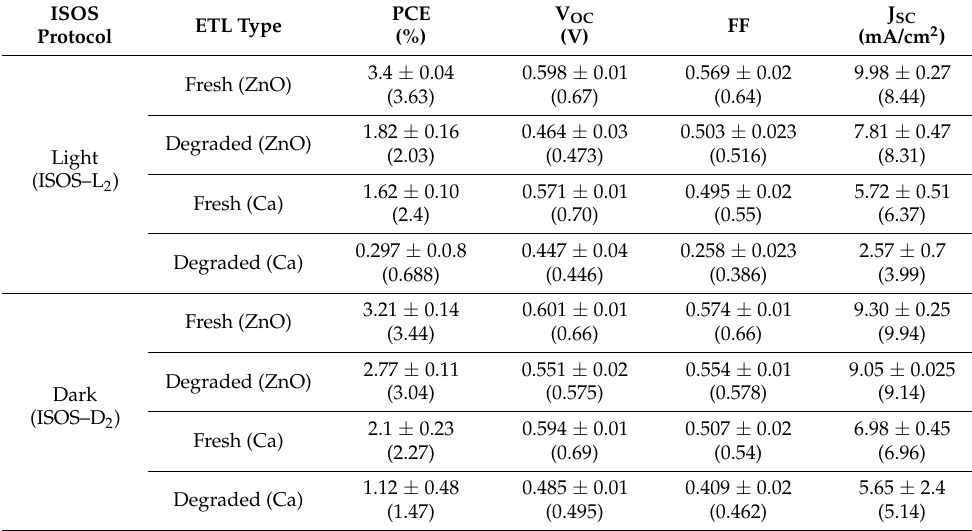
Figure 2. ( a ) J–V curves of the typical OPV device obtained for P3HT:ICxA with a Ca ETL layer under light condition ( c ) under dark condition; ( b ) J–V curves of the typical OPV device obtained for P3HT:ICxA with a ZnO ETL layer under light condition ( d ) under dark condition. The J–V charac- teristics are measured by applying linear sweep voltage to the photovoltaic device and evaluating the current using Keithley 2400 source meter. The simulator light intensity has been adjusted to 100 mW/cm 2 . Table 1. The electrical performance characteristic parameters of fresh and degraded OPV devices for the Ca or ZnO ETL layer under light as (ISOS − L 2 ) and dark (ISOS − D 2 ) protocols. Short circuit current (I SC ), open circuit voltage V OC , fill factor (FF), and power conversion efficiency (PCE) are extracted from J–V measurements and these have been used to provide fundamental information about the behavior and characteristics of the photovoltaic device (Average ± Standard deviation